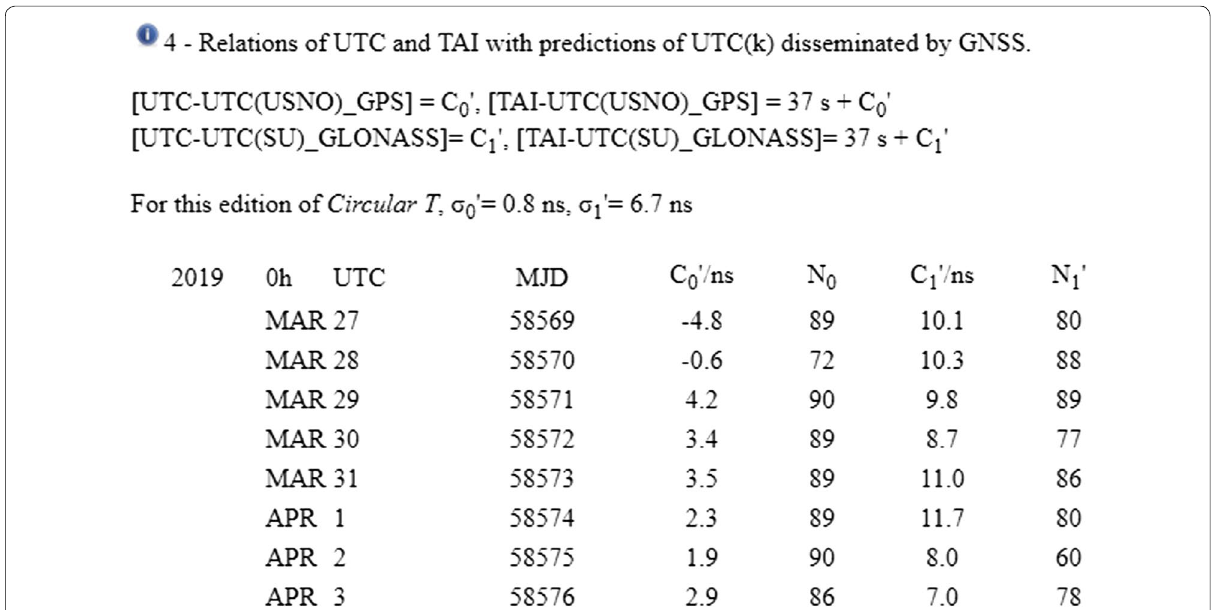
Fig. 11 Examples of the offset of UTC versus the UTC information broadcast by GPS and GLONASS in BIPM circular T